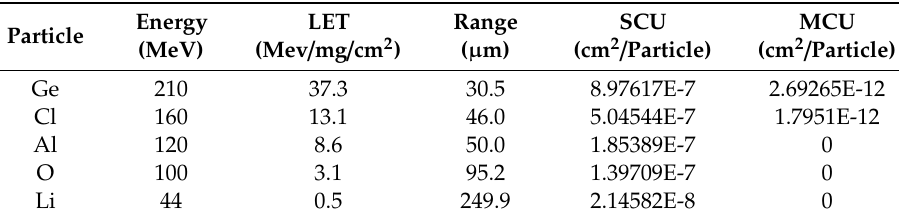
Table 1. Parameter of particles.